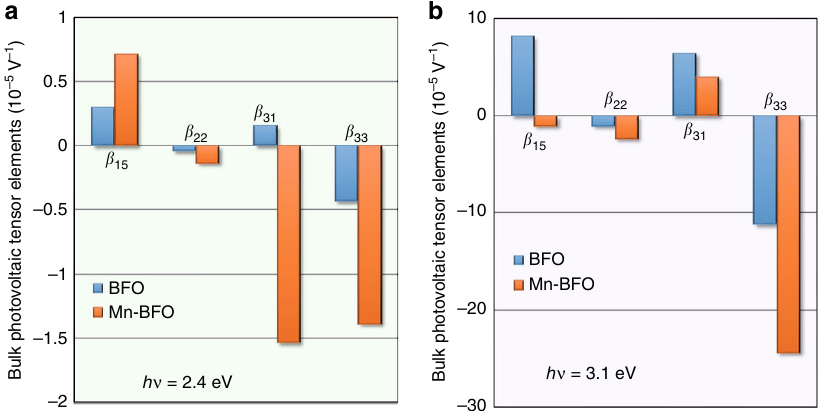
Fig. 5 Bulk photovoltaic (BPV) tensor elements ( β ij ). Under illumination at a h ν = 2.4 eV and b h ν = 3.1 eV estimated from light polarization angle ω dependences of short-circuit currents. The data of the BFO fi lm are shown in Supplementary Fig. 4 and that of the Mn-BFO fi lm are exhibited in Supplementary Fig.